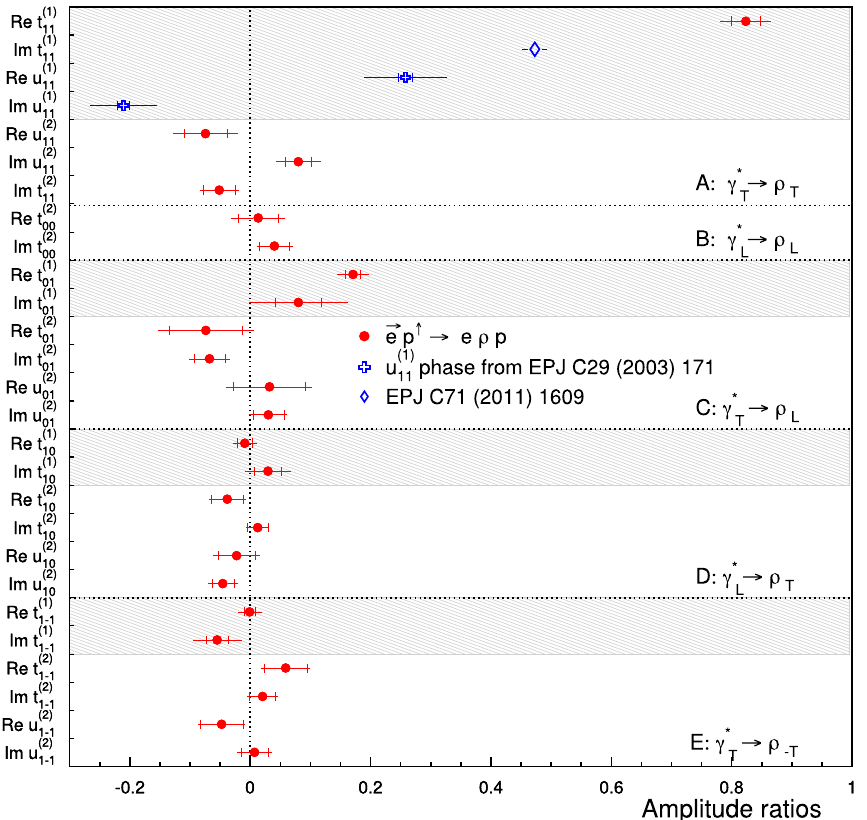
Fig. 2 Helicity-amplitude ratios obtained from the 25-parameter fit characterized by (cid:6) W (cid:7) = 4 . 73 GeV, (cid:6) Q 2 (cid:7) = 1 . 93 GeV 2 , (cid:6)− t (cid:2) (cid:7) = 0 . 132 GeV 2 , as explained in the text. While the phase of u ing to the results of Refs. [27,45,46], its modulus is fit so that the two crosses represent the results of fitting one free parameter. The value of ( 1 ) } ( open diamond ) represents the result of Ref. [27]; the error Im { t 11 bar shows the total uncertainty. For all other points, the inner error bars represent the statistical uncertainty, while the outer ones represent statistical and systematic uncertainties added in quadrature. An addi-